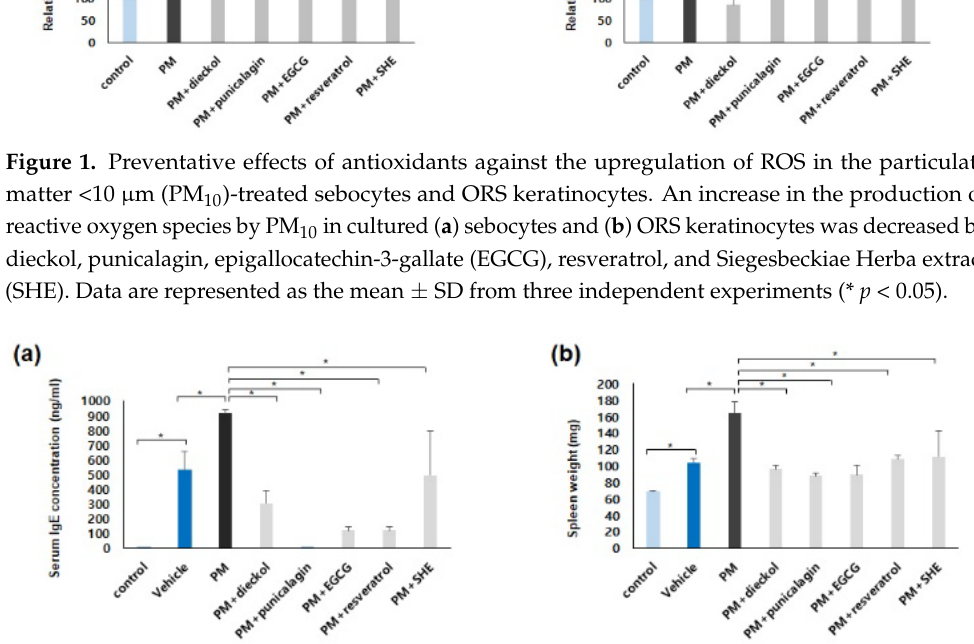
Figure 1. Preventative effects of antioxidants against the upregulation of ROS in the particulate mat- ter <10 μm (PM 10 )-treated sebocytes and ORS keratinocytes. An increase in the production of reac- tive oxygen species by PM 10 in cultured ( a ) sebocytes and ( b ) ORS keratinocytes was decreased by dieckol, punicalagin, epigallocatechin-3-gallate (EGCG), resveratrol, and Siegesbeckiae Herba ex- tract (SHE). Data are represented as the mean ± SD from three independent experiments (* p < 0.05).